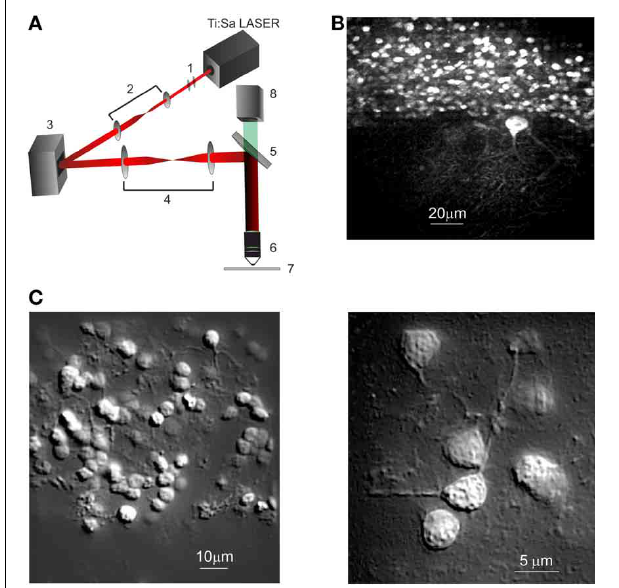
FIGURE 1 | Spatial light modulator—two-photon microscope (SLM-2PM). (A) Schematic representation of the SLM-2P Moptical system. (1) Polarizer and half-wave plate, (2) beam expander, (3) SLM, (4) beam reducer, (5) dichroic mirror, (6) objective, (7) specimen, (8) CMOS camera. (B) SLM-2PM image of a cerebellar slice bulk-loaded with Fura-2AM, illuminated with sliding grid scan and reconstructed at low magnification (20 × objective). Several GrCs and one PC with a large dendritic tree are visible. (C) SLM-2PM images processed offline to show neuronal details. A portion of the granular layer ( left , 40 × objective) shows numerous GrCs and their neuritic prolongations. Three GrCs ( right , 60 × objective) send their dendrites toward a common point, presumably corresponding to a mossy fiber